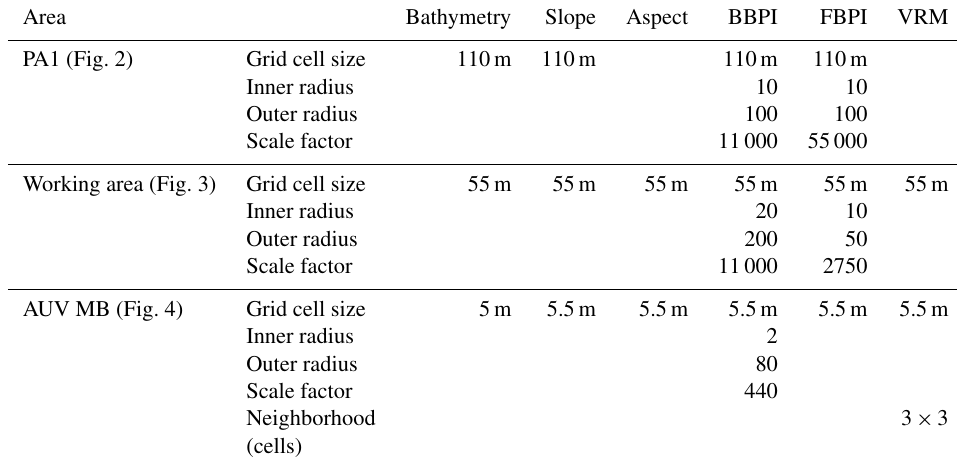
Table A1. Metadata of the created maps including raster cell sizes for the considered regions and subregions.